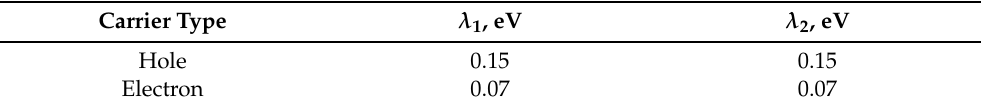
Table 1. Hole and electron reorganization energies for the porphine molecule obtained by the M062X/cc-pVTZ level of